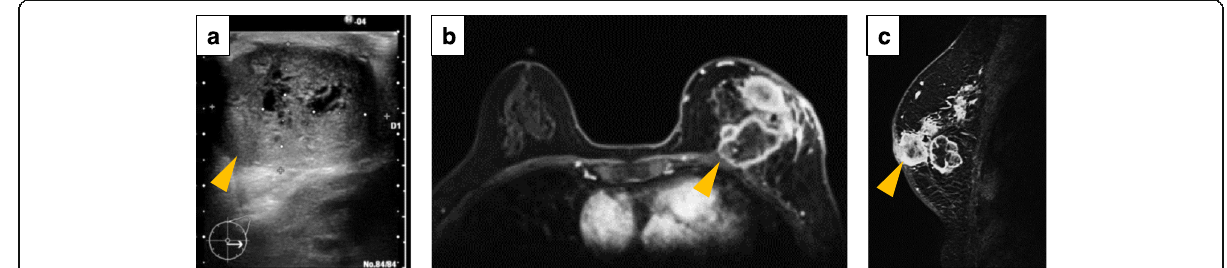
Fig. 2 The data of the secondary operation. a An ultrasonography (US) scan of the breast demonstrated a scale out size of low echoic mass (orange arrowhead). b A magnetic resonance imaging (MRI) showed some tumors including internal necrosis with ductal spread (orange arrowhead). The pectoralis muscle invasion was suspected. c A sagittal sequence of MRI scans showed the wide ductal spread of malignant adenomyoepithelioma (AME), which invaded the skin (orange